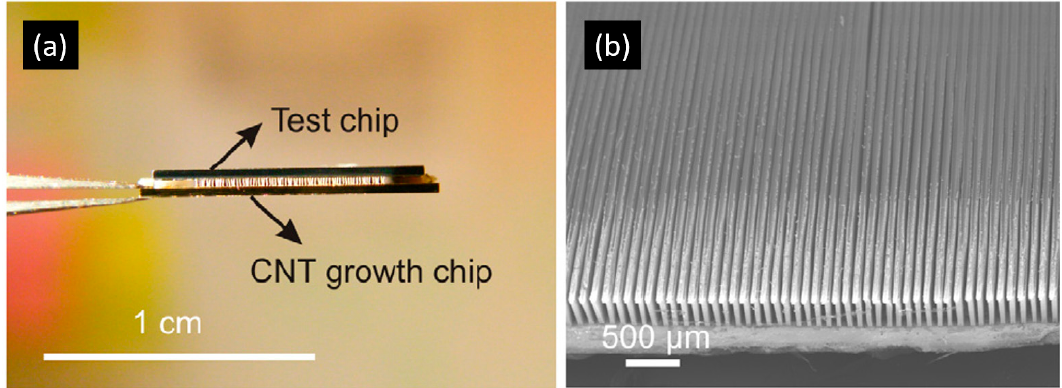
Figure 3. Transferred CNT cooling fins directly fabricated on top of the hotspot test structure. Reprinted with permission from Reference [22].